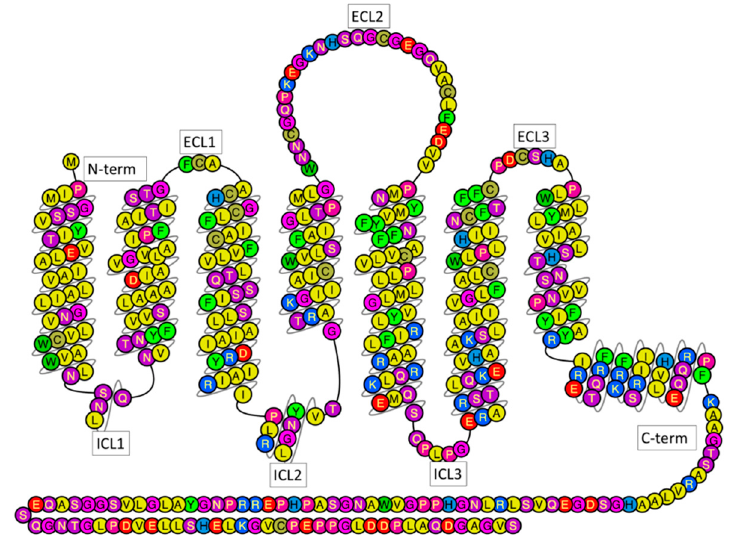
Figure 1. Snake view of hA 2A R sequence, generated by GPCRDB [16]. Residues are colored differently depending on their polarity.